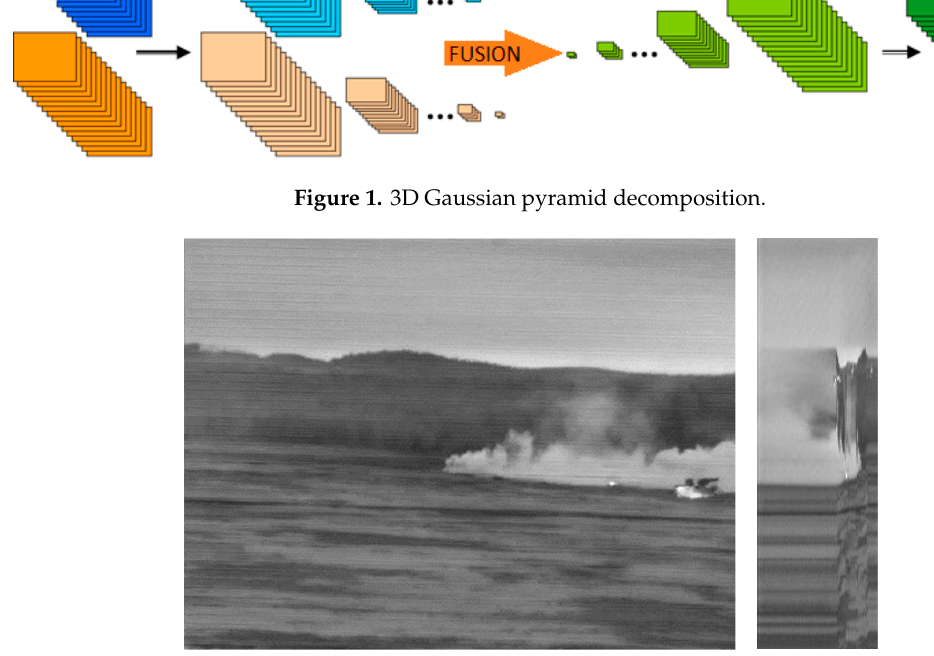
Figure 2. Polyview representation of mean opinion score (MSO1) sequence.